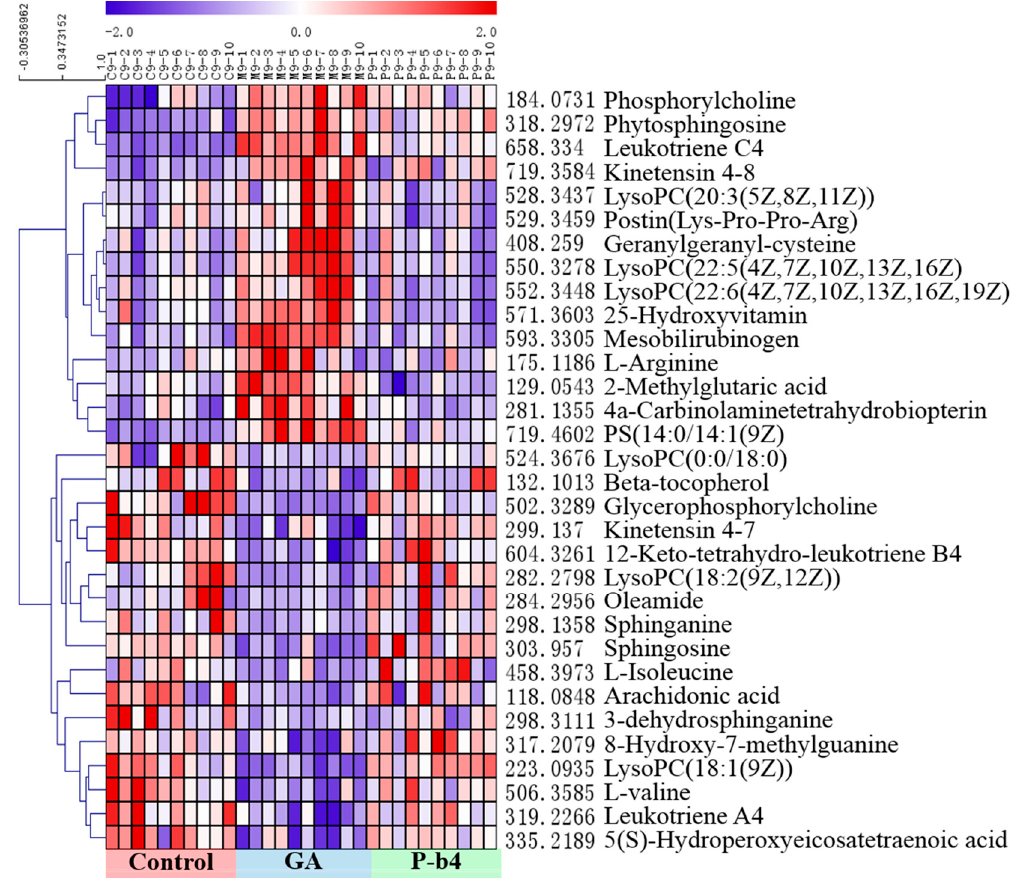
Figure 5. The heatmap of 32 potential biomarkers of rat serum samples at 9 h. The color of each section corresponds to a concentration value of each metabolite, red indicates an up-regulation of metabolites and blue indicates a down-regulation of metabolites.